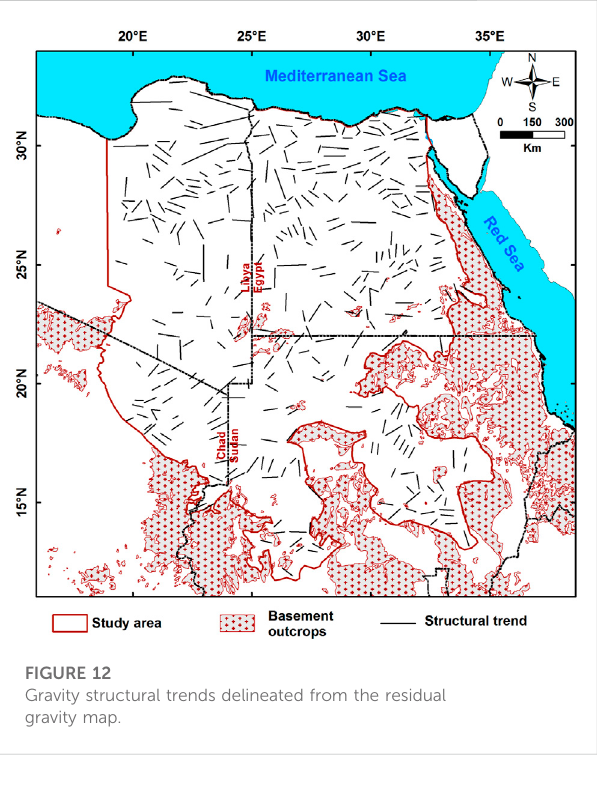
FIGURE 14 Rose diagram for the structural trends interpreted from the: (A) high-pass fi ltered gravity map, (B) regional gravity map, (C) residual gravity map, (D) gravity map on the basement surface, and (E) basement and Jurassic rocks in north Western Desert, showing the NE – SW trend is the main structural trend affecting the area and minor trends in the E – W, N – S, and NW – SE directions.